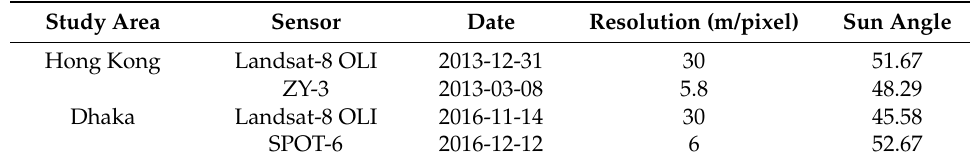
Table 1. Description of the satellite data.